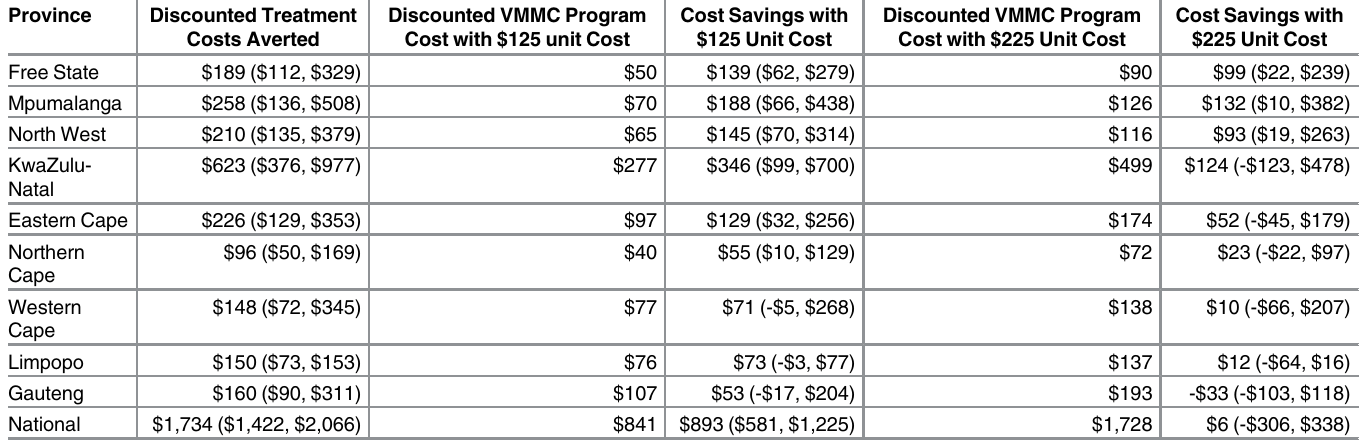
Table 4. Cost Savings of the VMMC Program in Each Province, Millions, USD, (2014 – 2028).